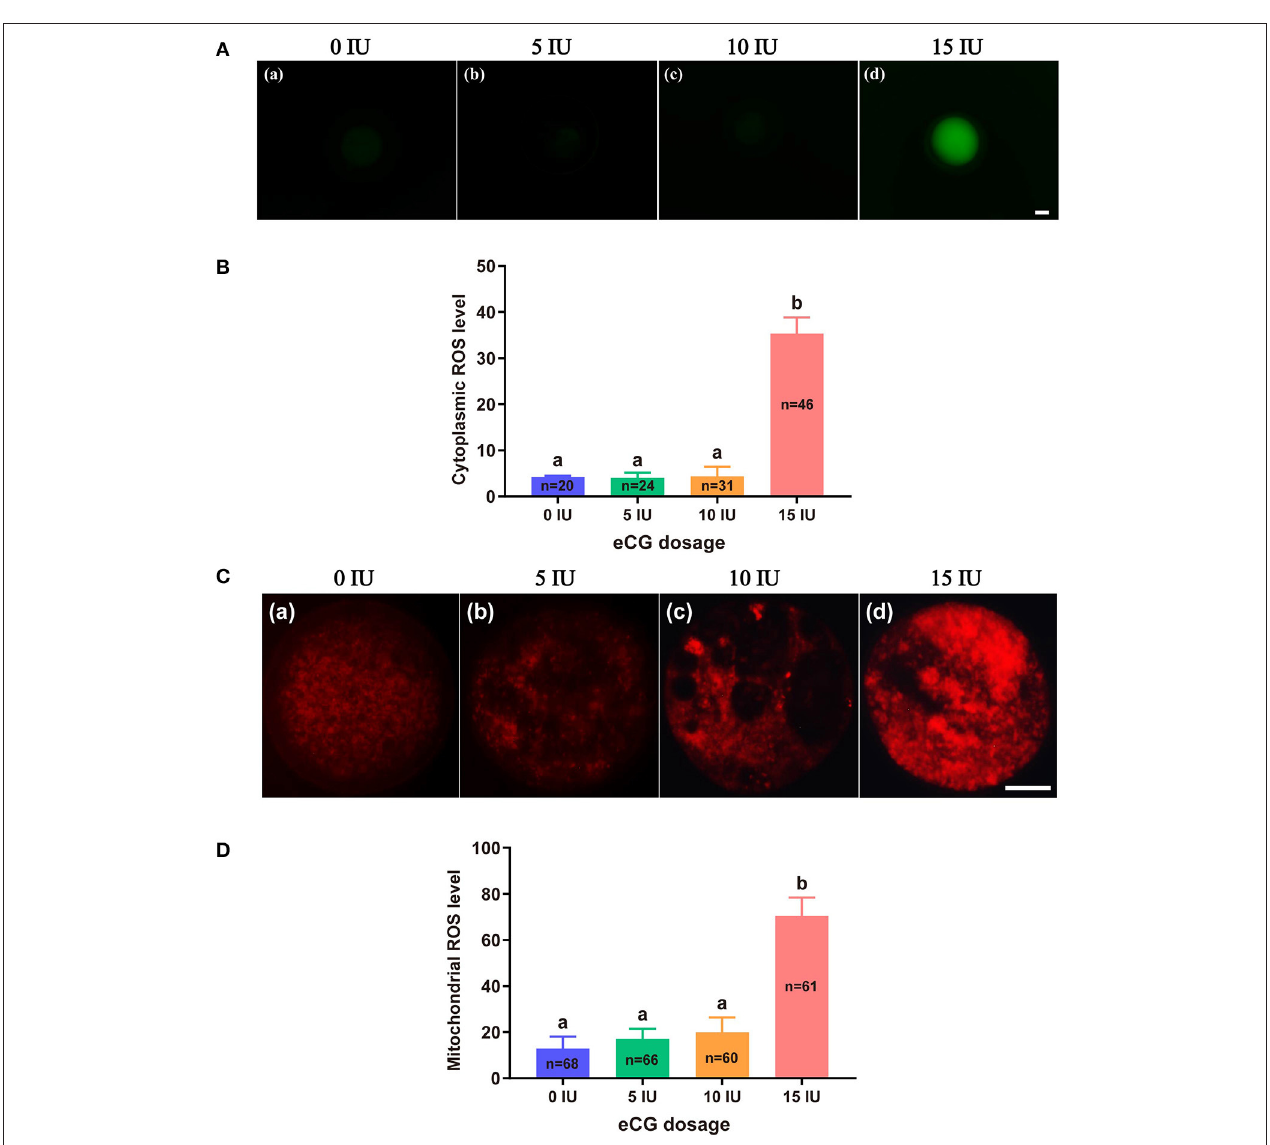
FIGURE 2 | Effects of different eCG doses on ROS concentrations in IVF-derived mouse embryos. (A) Representative images of cytoplasmic ROS in embryos after administration of eCG at doses of 0, 5, 10, and 15 IU (a–d). Scale bar = 20 µ m. (B) ROS production in the cytoplasm was assessed by staining with DCFH-DA. The cytoplasmic ROS levels of the embryos in the group treated with the high dose (15 IU) of eCG were significantly higher than those of the embryos in the other three groups. (C) Representative images of mitochondrial ROS in embryos after administration of eCG at doses of 0, 5, 10, and 15 IU (a–d). Scale bar = 20 µ m. (D) ROS production in mitochondria was assessed using the mitochondrial superoxide indicator MitoSOX TM Red. The mitochondrial ROS levels of the embryos in the group treated with the high dose (15 IU) of eCG were significantly higher than those of the embryos in the other three groups. The continuous FI data were analyzed using Student’s t -test and ANOVA. a,b Bars labeled with different letters are significantly different from each other ( P < 0.05). n shows the total number of embryos detected.